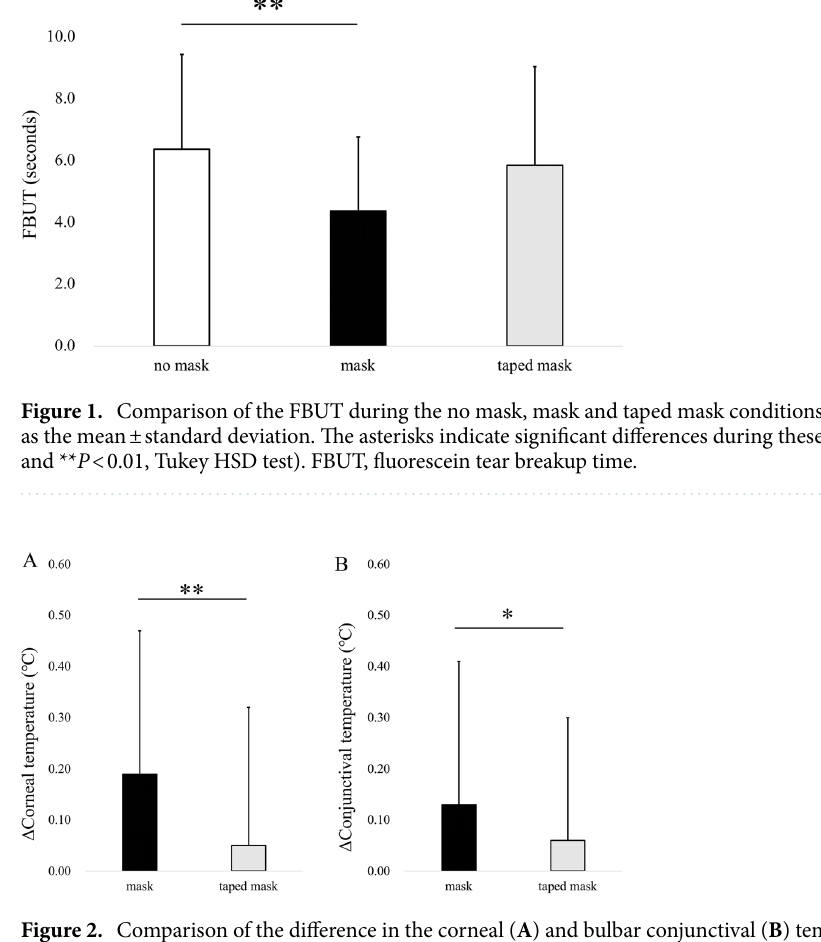
Figure 2. Comparison of the difference in the corneal ( A ) and bulbar conjunctival ( B ) temperatures between the no mask and mask or taped mask groups. The asterisks indicate significant differences during these conditions (* P < 0.05 and ** P < 0.01, paired t-test).